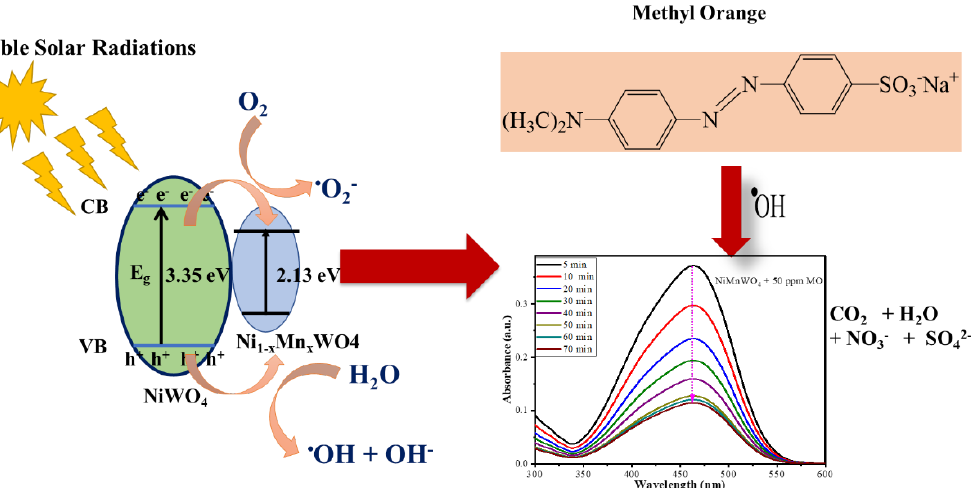
Figure 10. Schematic diagram showing the mechanism of photodegradation of MO by Ni 1 − x Mn x WO 4 NC under visible light source.